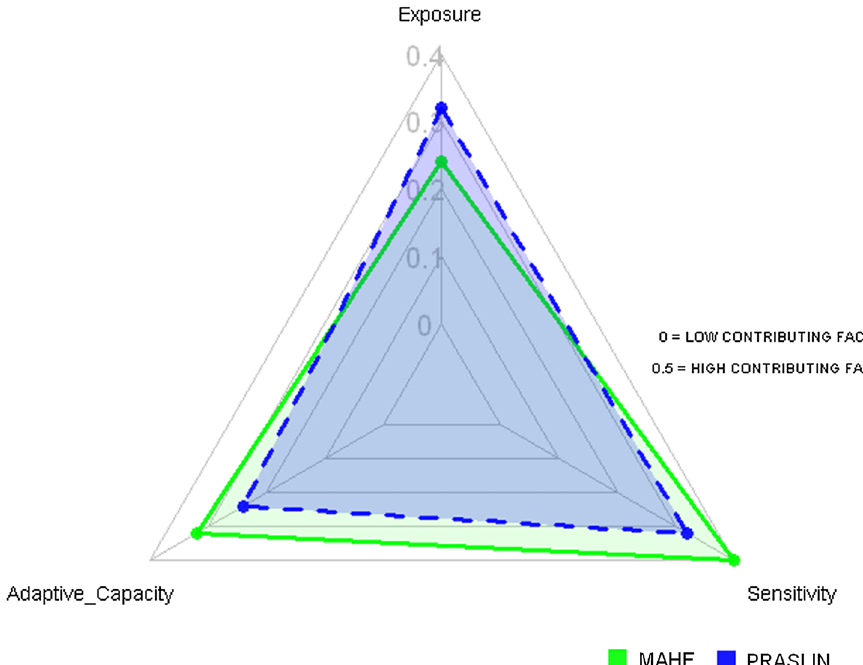
Fig. 3 Vulnerability triangle diagram for the contribut- ing factors of the Livelihood Vulnerability Index-IPCC (LVI- IPCC) for Mahe and Praslin